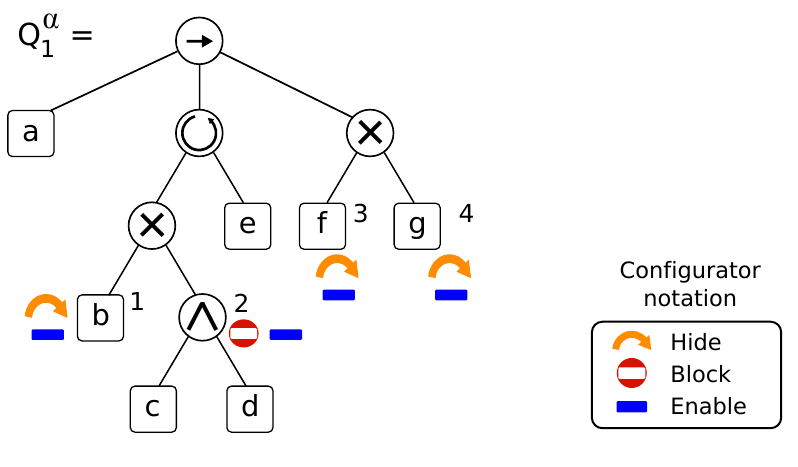
Figure 4. Example of a configurable process tree containing four configurable